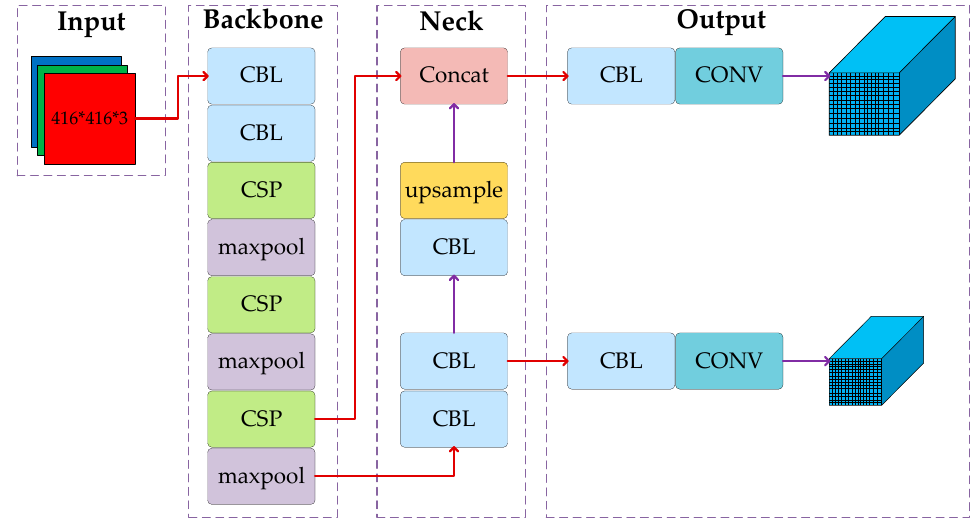
Figure 2. Structure of the YOLOv4-tiny